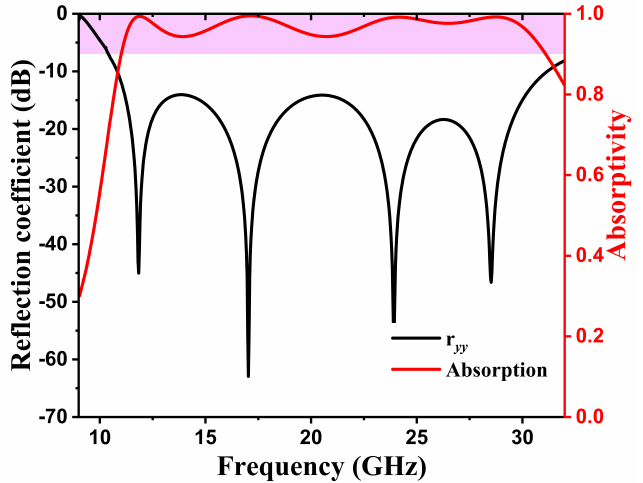
Figure 3. Reflection coefficient and absorptivity of the proposed structure.